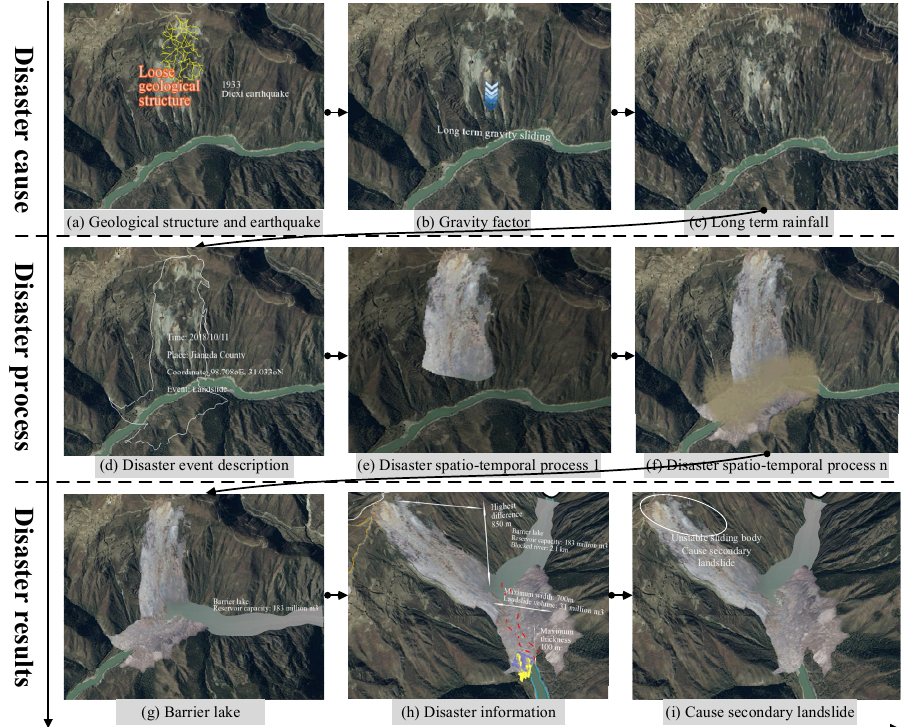
Figure 7. Dynamic visualization effect of knowledge ‐ guided landslide disaster scene.